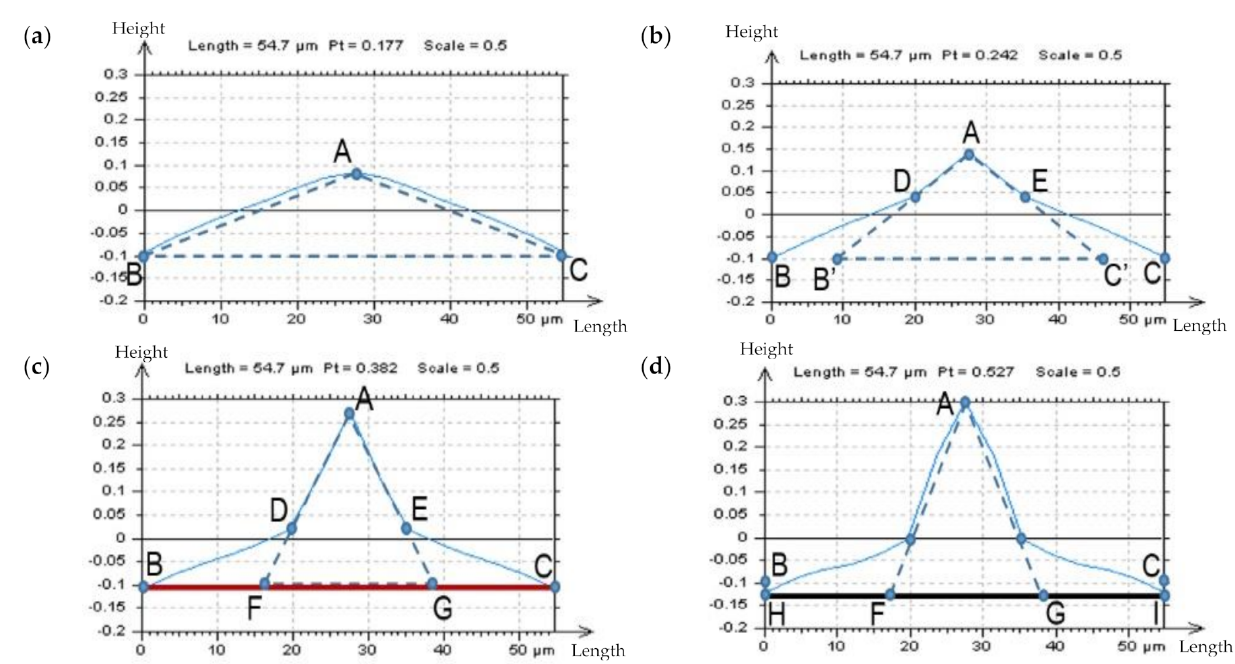
Figure 5. The method for a partial–detection of the HFN from measurement results of turned detail, based on the ACF diagram analysis. ACF diagrams of profiles with no HFN ( a ) and containing small ( b ), medium ( c ) and a lot ( d ) of